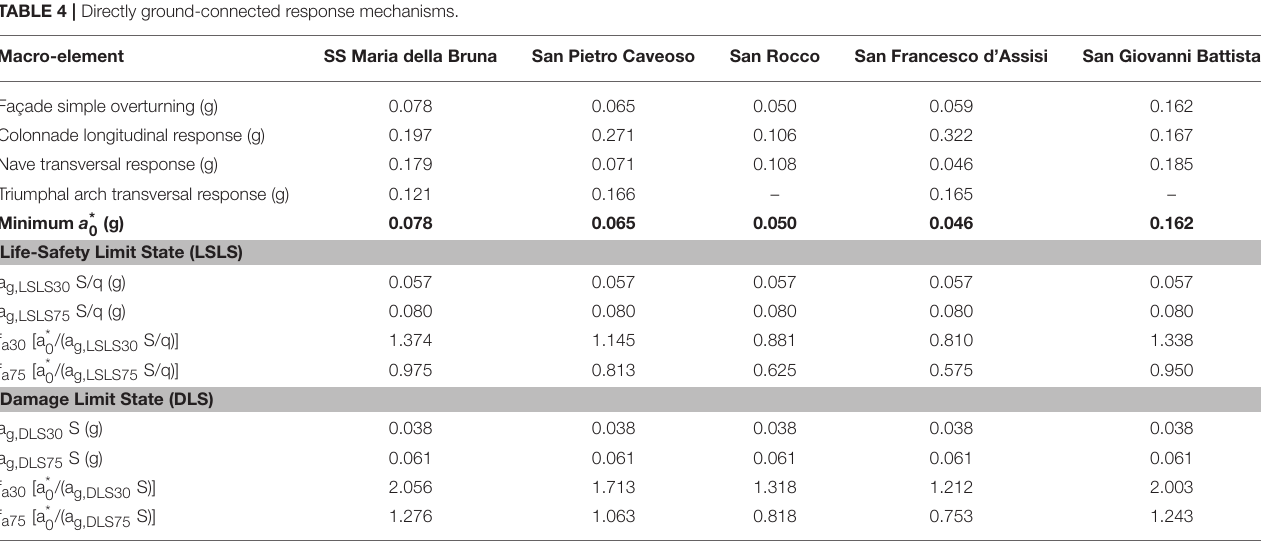
TABLE 4 | Directly ground-connected response